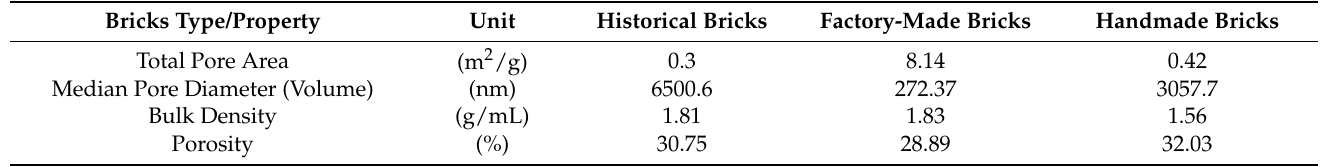
Table 6. Brick parameters determined during porosimetric analysis.